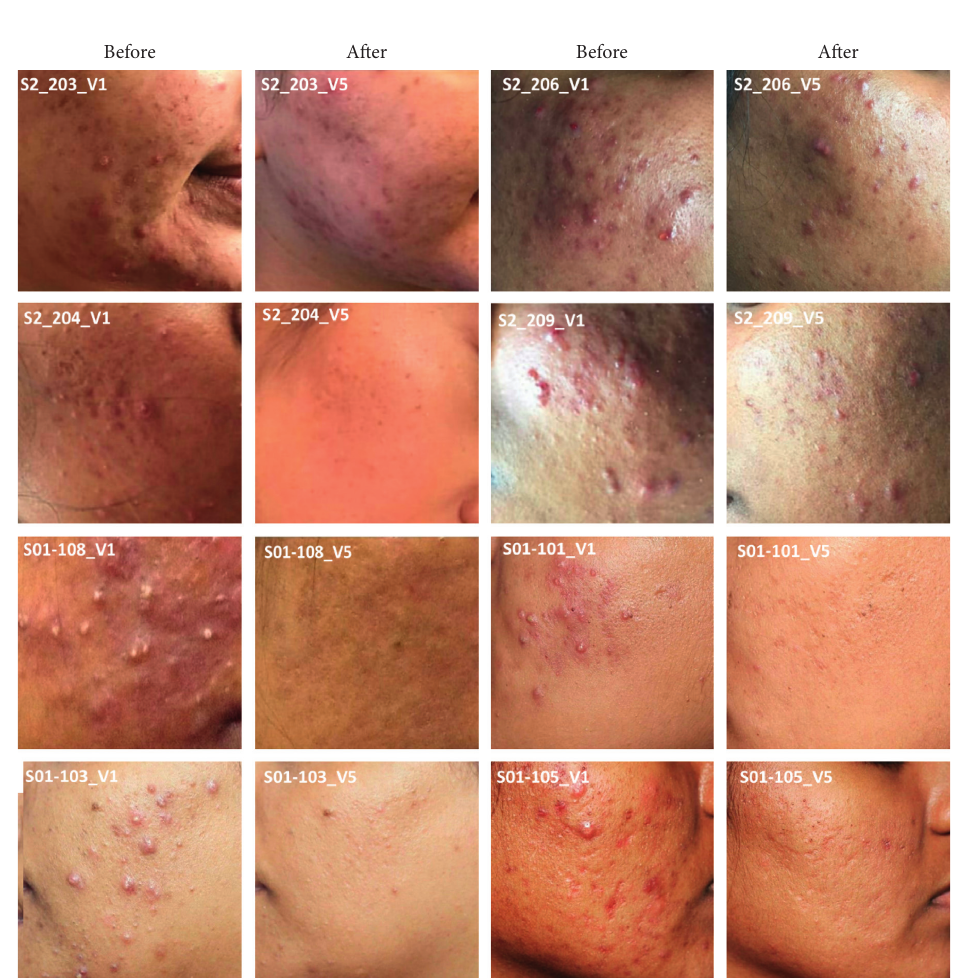
Figure 3: Representative skin lesion images before (week 0) and after (week 24) treatment. The different labels on the picture represent different patient ids including the site number (S1 or S2), patient number (###), and visit (V1 or